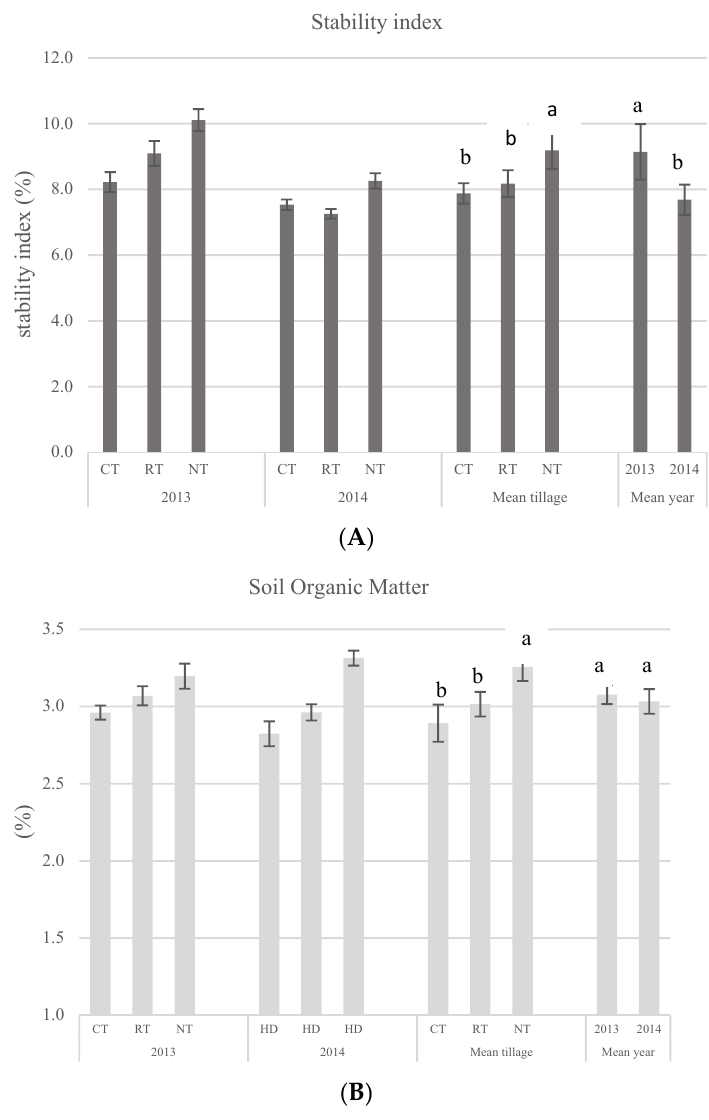
Figure 4. ( A ) Stability index and ( B ) organic matter content in the soil with respect to tillage system (CT — conventional; RT — reduced; N — no tillage) and study year at E. Pantanelli experimental farm in Policoro (southern Italy). Different letters within each group indicate significant differences according to the Student Newman – Keuls (SNK) multiple-range test ( p ≥ 0.05).